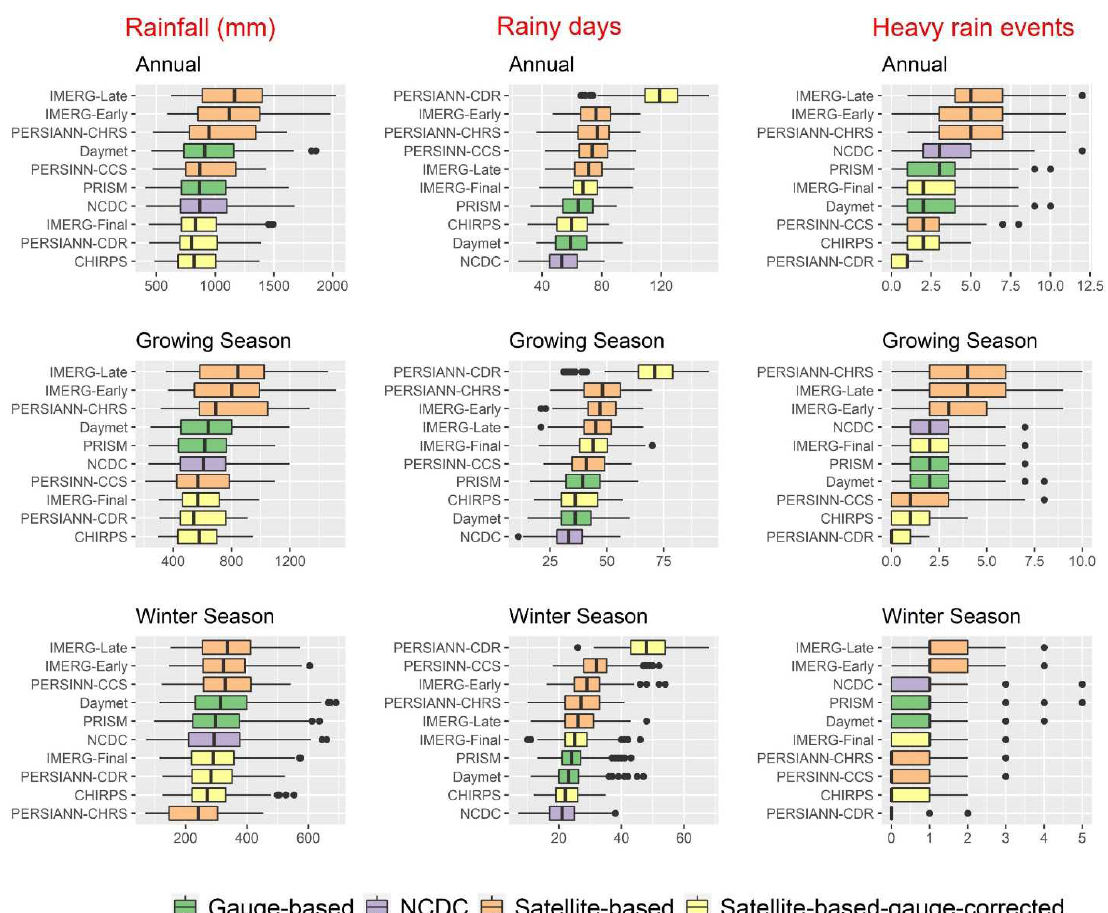
Figure 5. Annual and seasonal precipitation, number of rainy days (precipitation > 1mm), and num- ber of heavy rain (>50 mm) events for different precipitation datasets. Note: growing season June- October and winter season